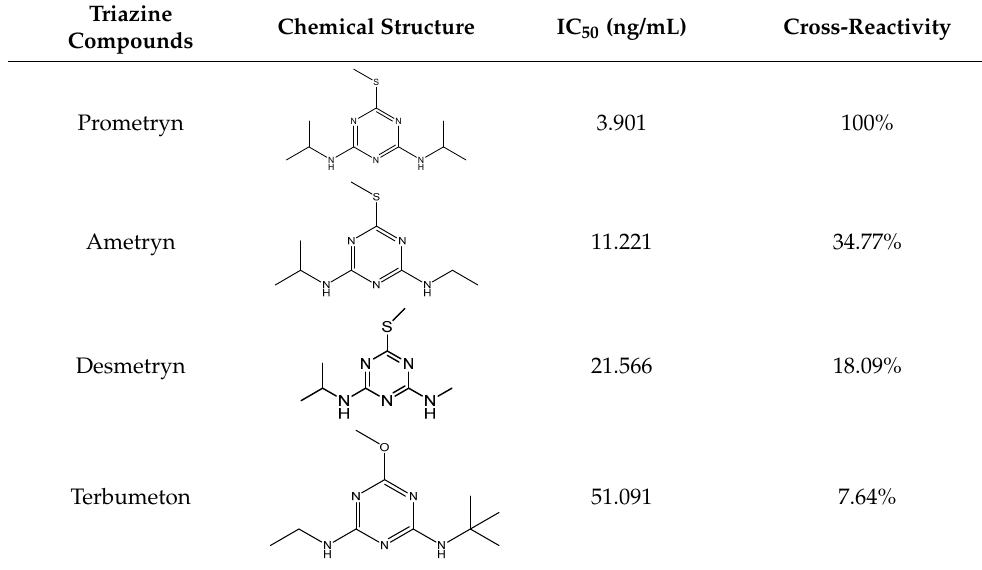
Table 1. The results of the cross-reactivity of the 7D4 mAb with other triazines. Triazine